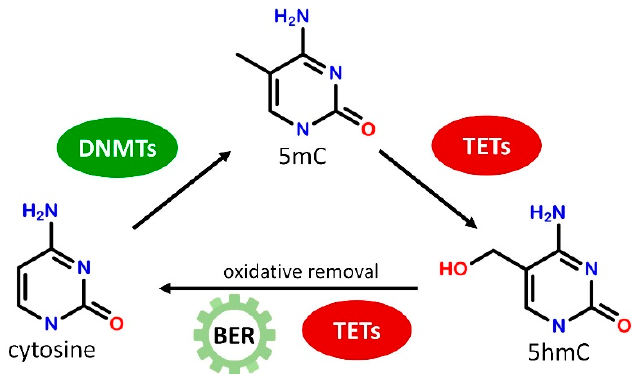
Figure 1. Schematic illustration of the generation and removal of 5-methylcytosine (5mC) marks. Cytosines in the CpG context can be methylated by DNA methyltransferases (DNMTs). 5mC can be converted to 5-hydroxymethylcytosine (5hmC) by Ten-Eleven Translocation (TET) dioxygenases, and then can be removed by the multistep action of TET enzymes and base excision repair (BER).